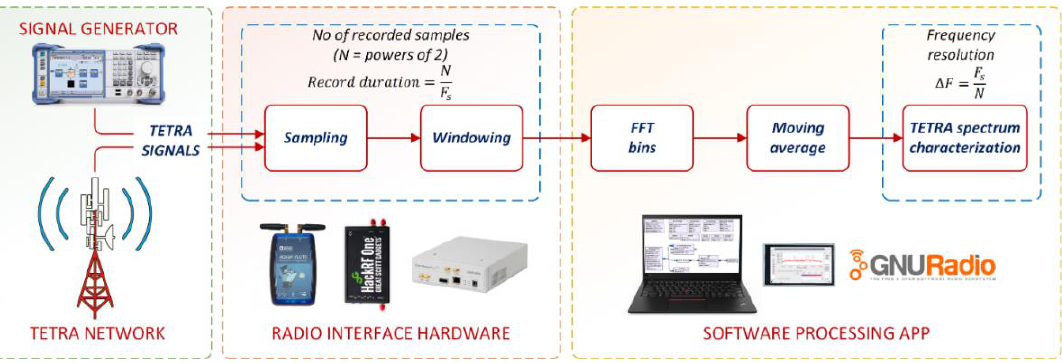
Figure 1. Data acquisition and processing steps used to characterize, in detail, the TETRA signals. The radio interface based on the SDR platform acquires the TETRA signals, transforms them into digital format and records them sequentially. Subsequently, the IQ signal samples obtained at the output of the radio interface are applied to the FFT processor for characterization in the frequency domain. The frequency resolution obtained is given by the ratio between the sampling frequency Fs and the number of points N necessary for the FFT calculation, as shown in Relation (1), based on [27]: